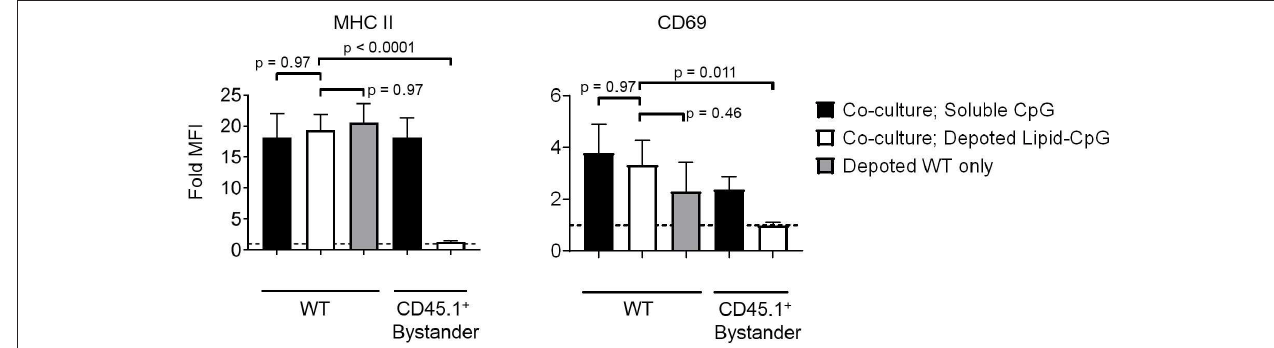
FIGURE 5 | Depoted TLR ligands activate cells through autocrine signaling. Wildtype (WT) B cells were depoted with 5 µ M of lipid-CpG and co-cultured with CD45.1 + bystander B cells. MHCII and CD69 on both depoted (WT) and bystander (CD45.1 + ) B cells were measured after 2 days of co-culture by flow cytometry and normalized to respective unstimulated B cells. Dashed line represents theoretical no activation (MFI = 1). Indicated p -values were determined by RM one-way ANOVA with Sidak’s method for multiple comparisons correction. Data showed m ± s.d. ( n = 4 independent